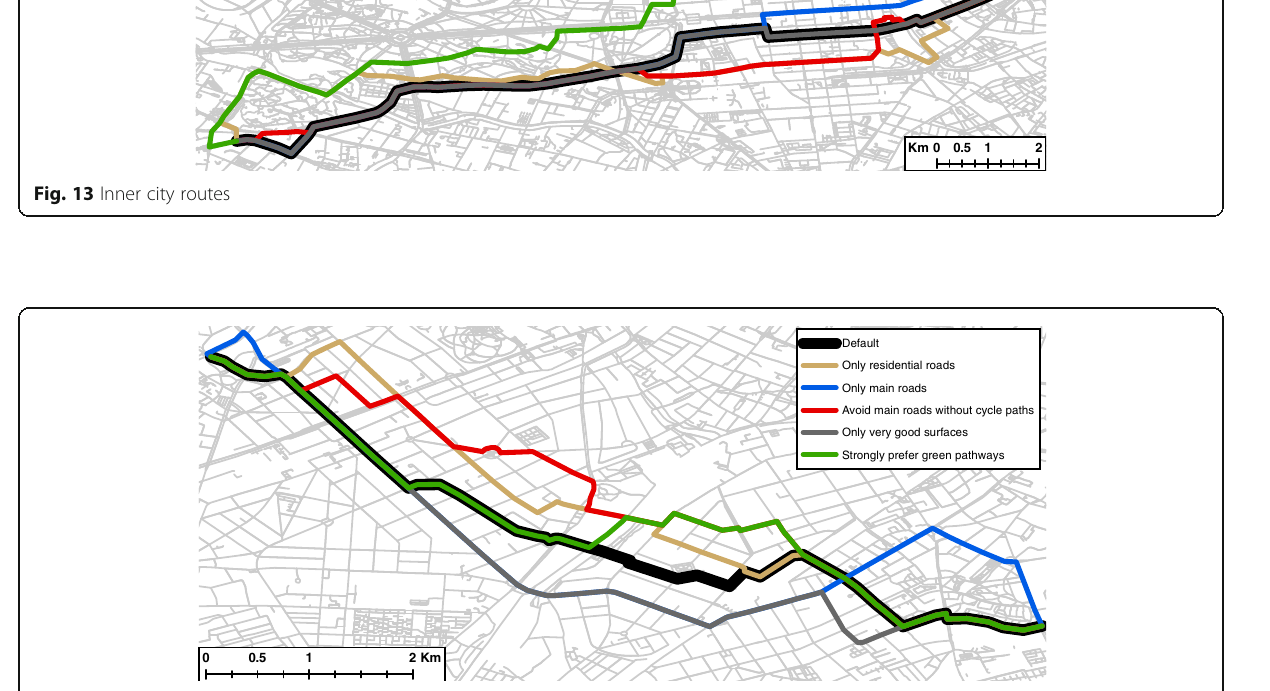
Fig. 14 Edge of town